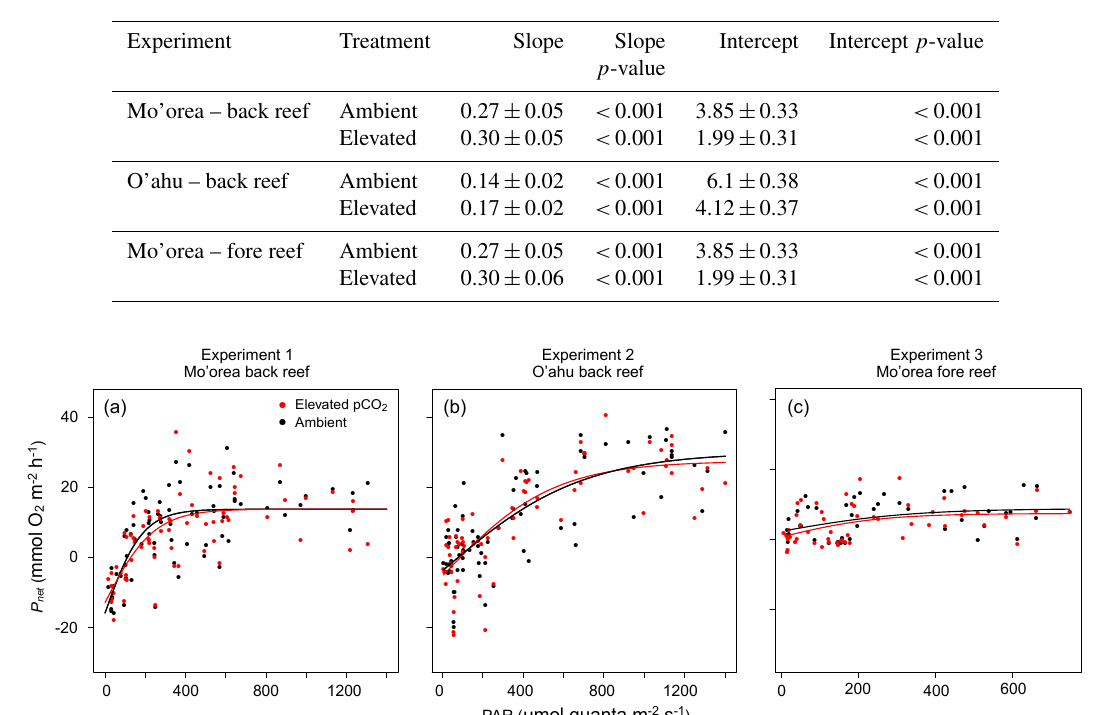
Table 3. Results of the linear regressions modeling the P net – G net relationships under ambient and elevated p CO 2 . Results are shown for the experiments with back reef communities in Mo’orea and O’ahu, and fore reef communities in Mo’orea.